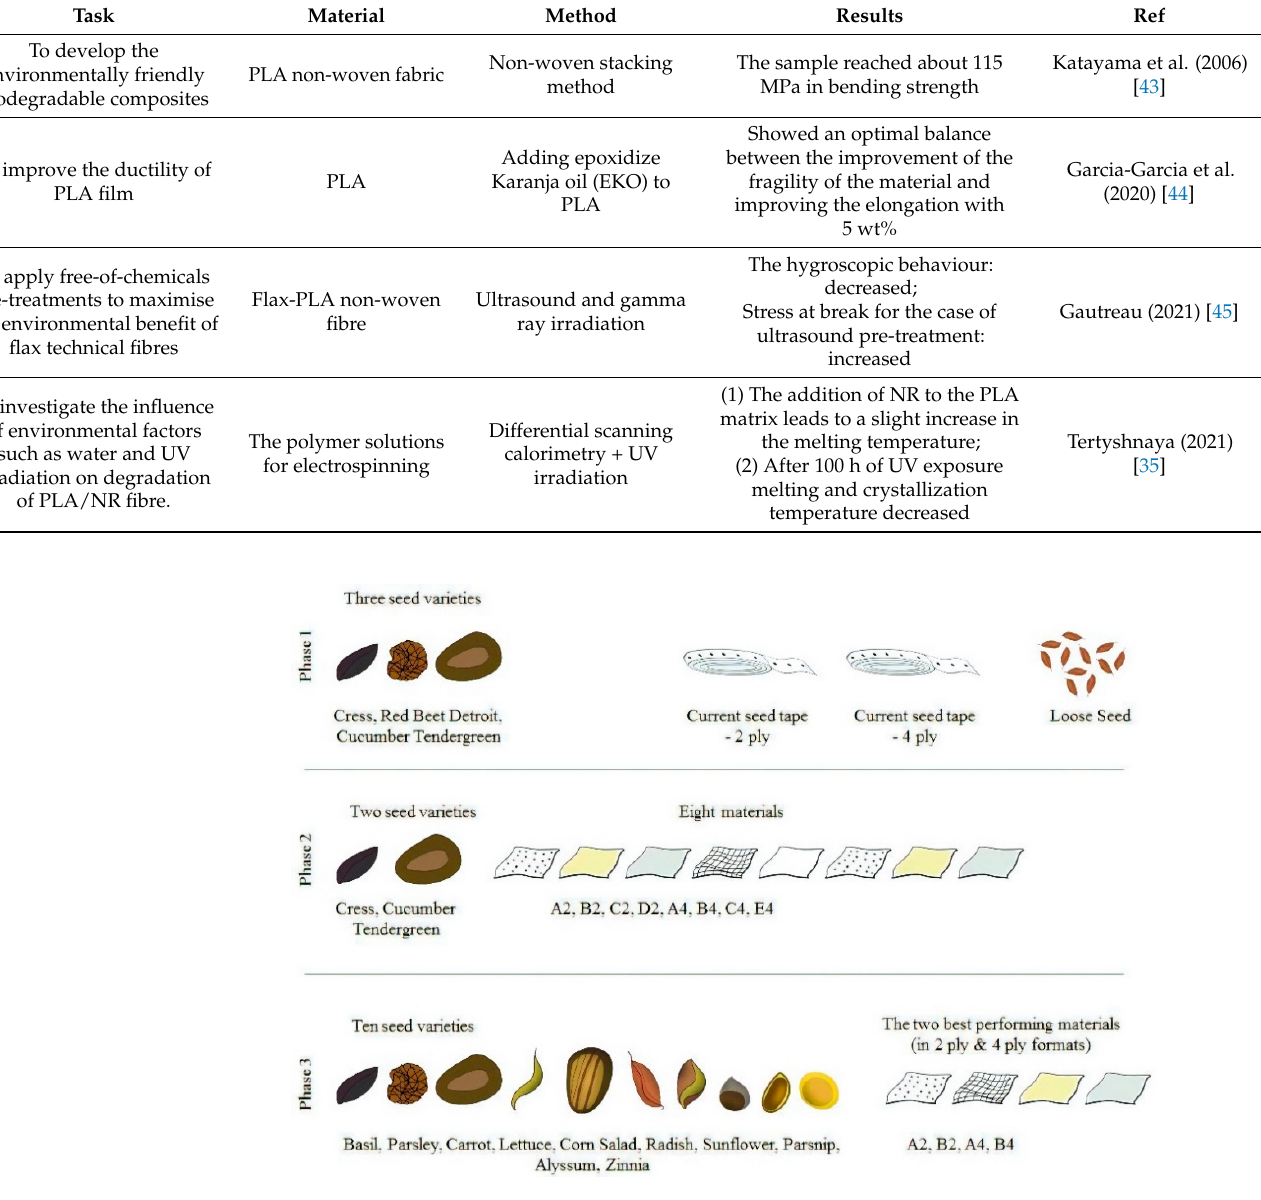
( c ) Figure 2. Three different types of seed tapes. ( a ) Folding type seed tape (https://patentimages.storage.goog- leapis.com/3d/48/6b/a92c63f9077c3f/US20110271888A1.pdf (accessed on 21 November 2021)) [46] ( b ) Device for making water-soluble